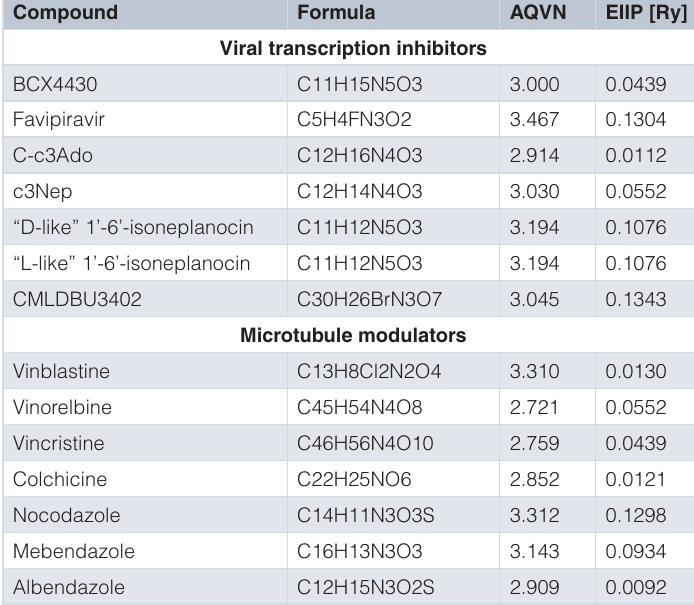
Table 2. Viral transcription inhibitors and microtubule modulators with anti-Ebola virus